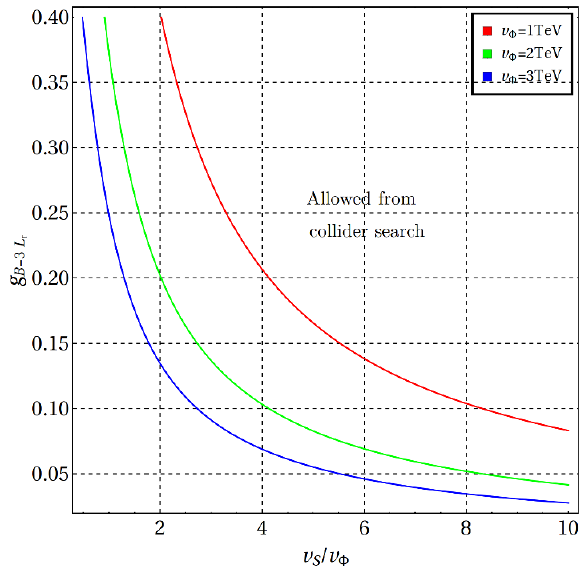
Figure 2 . Contours satisfying m Z ’ 2 : 5 TeV are shown following eq. (2.14) for three di(cid:11)erent B (cid:0) 3 L(cid:28) choices of v (cid:8) : f 1 : 0 ; 2 : 0 ; 3 : 0 g TeV in red, green and blue